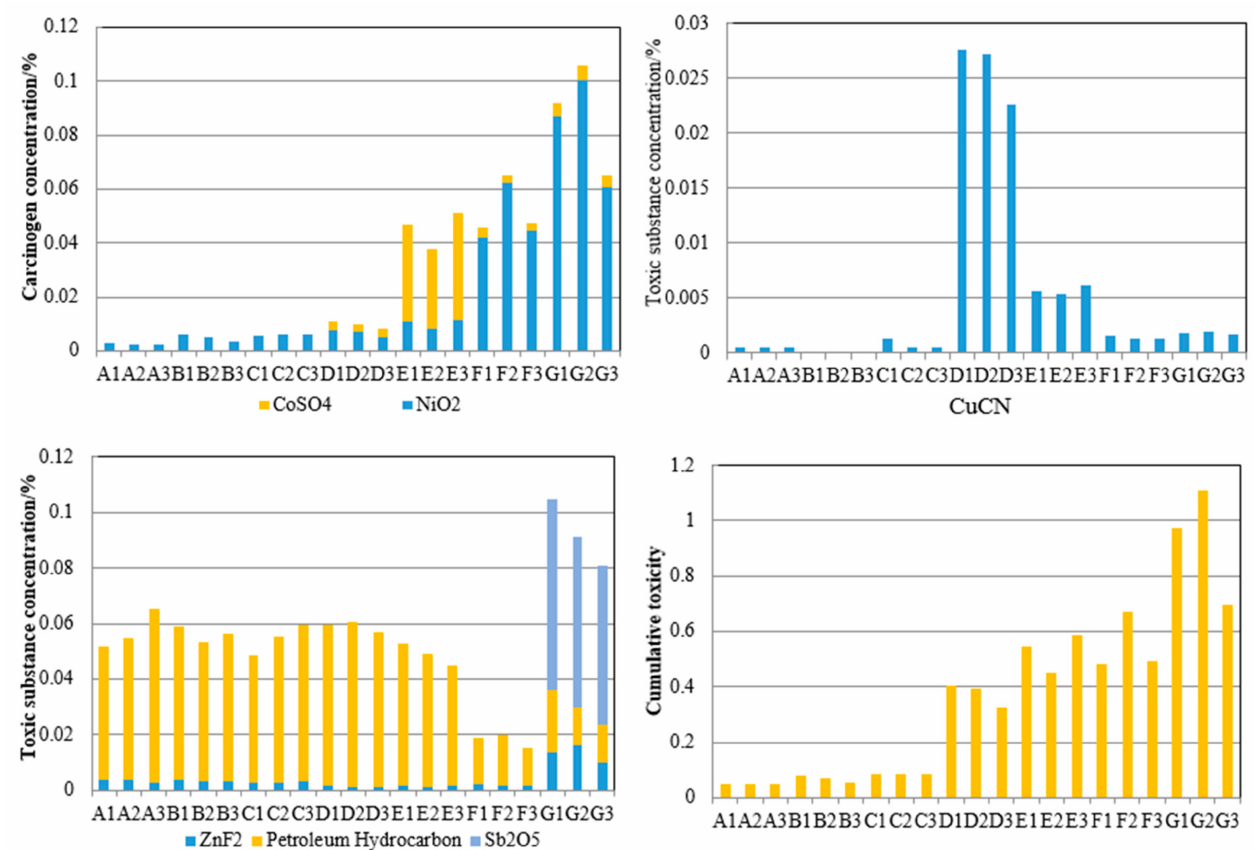
Figure 3. Cumulative toxicity of toxic substances in FCC spent catalyst samples from different units.